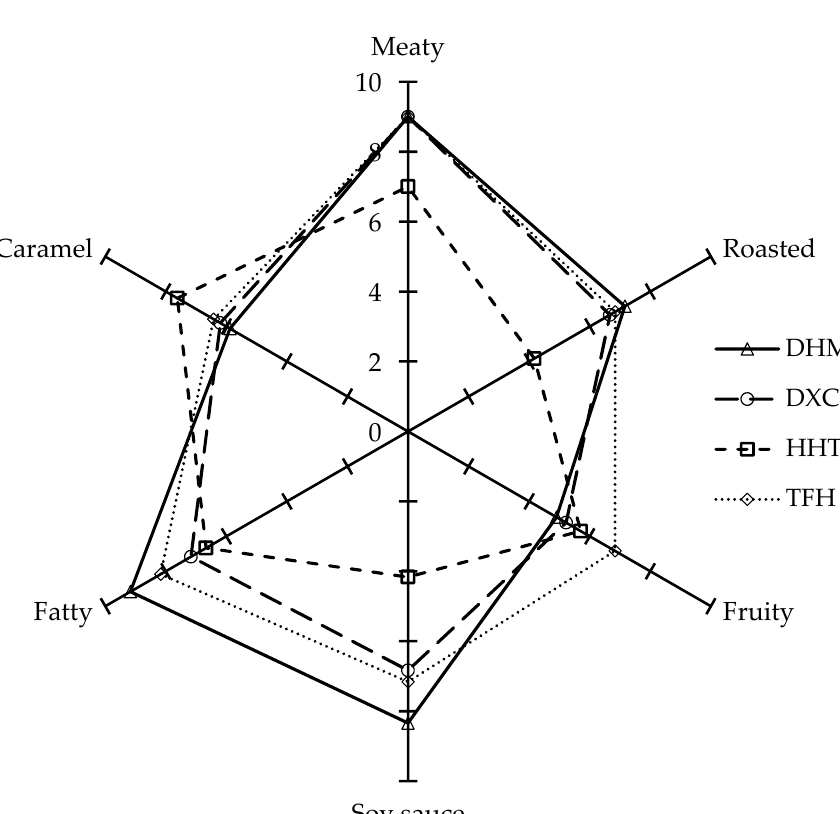
Figure 4. Radar charts of sensory analysis of the marinated pork hocks.